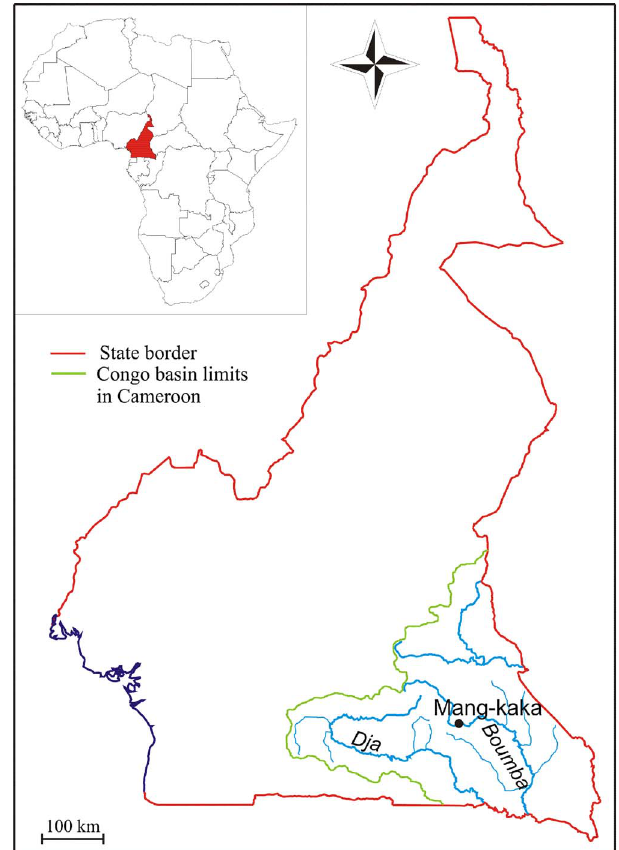
Figure 1. Map of the Boumba River with sampling